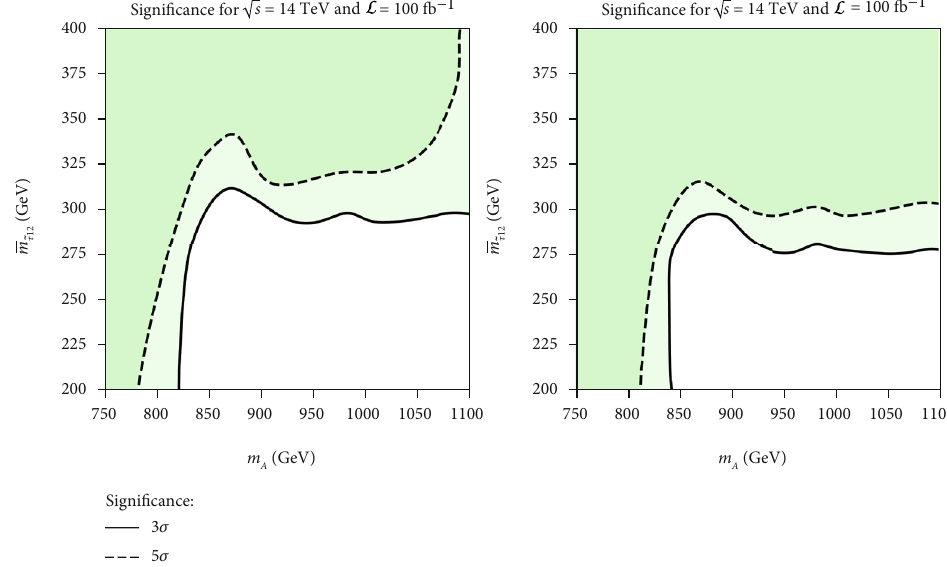
ffiffi p = 14 TeV and total integrated s